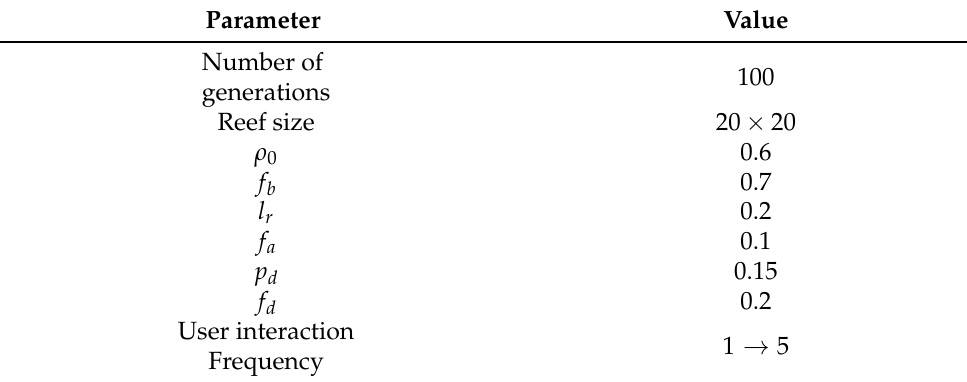
Table 1. Chosen MICRO algorithm